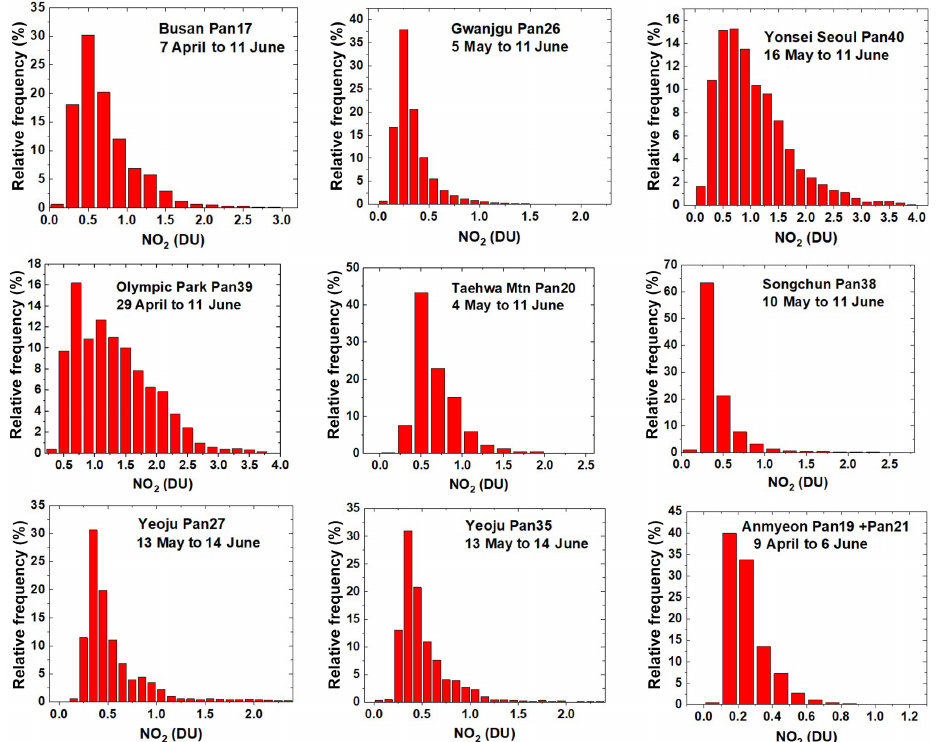
Figure 3. Frequency distributions of C ( NO 2 ) across the KORUS-AQ PSI network: 20 April to 6 June 2016, except as labeled. The axes vary for different